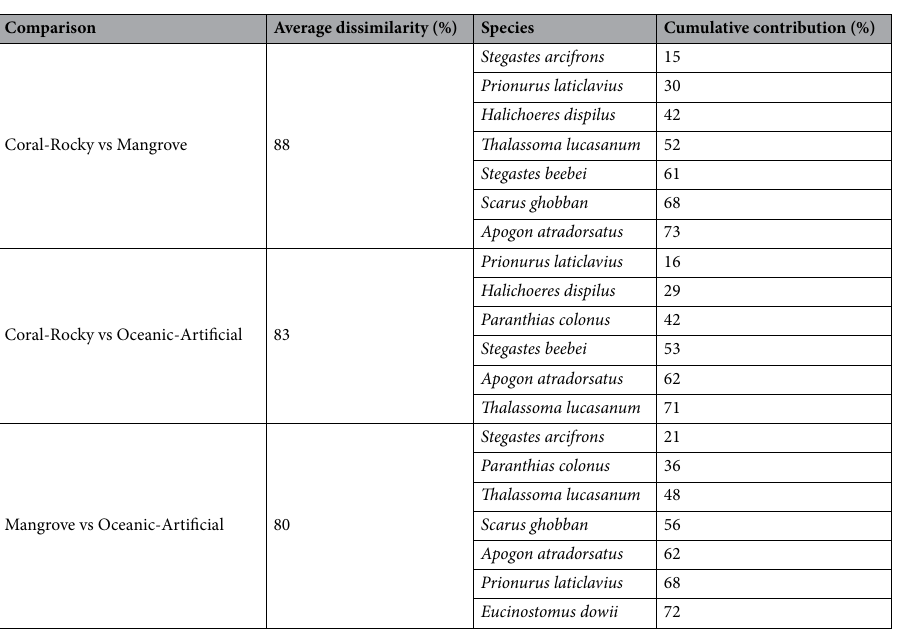
Table 3. SIMPER results showing the average between-group dissimilarities and species that contributed more to those dissimilarities.